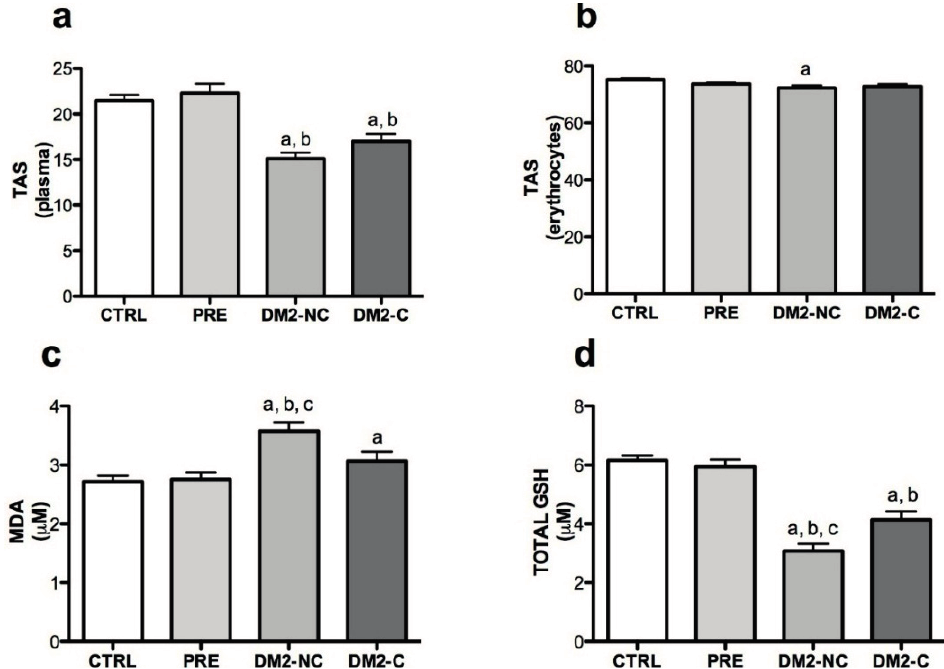
Figure 1. Oxidative markers in the studied groups. ( a ) Total antioxidant status (TAS) expressed as % of 2,2-diphenyl-1-picrylhydrazyl (DPPH) scavenging in plasma and ( b ) erythrocytes; ( c ) malondialdehyde (MDA) levels in plasma; ( d ) total glutathione (GSH) and ( e ) reduced form of GSH concentrations in plasma. CTRL: control, PRE: prediabetes, DM2-NC: diabetic subjects without glycemic control (glycated hemoglobin ≥ 7%), DM2-C: diabetic subjects under glycemic control (glycated hemoglobin < 7%). Each bar represents mean ± S.E. Statistical significance p < 0.05: a vs. CTRL and b vs. PRE c vs. DM2-C with a Wilcoxon rank-sum